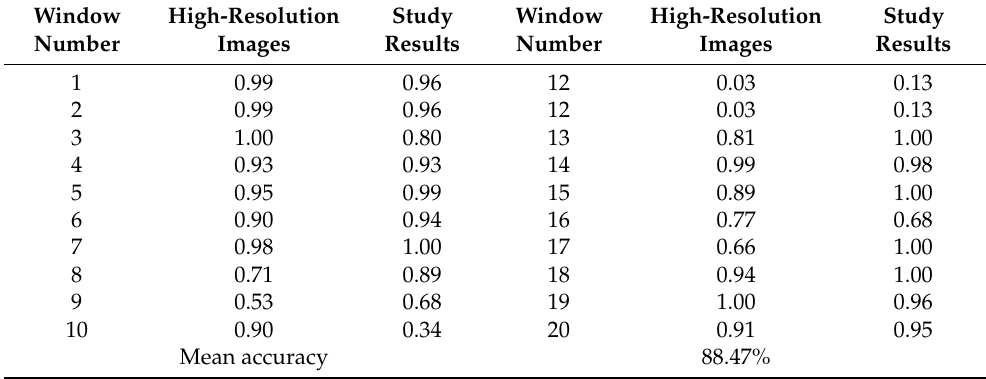
Table A5. Verification results of FVC in